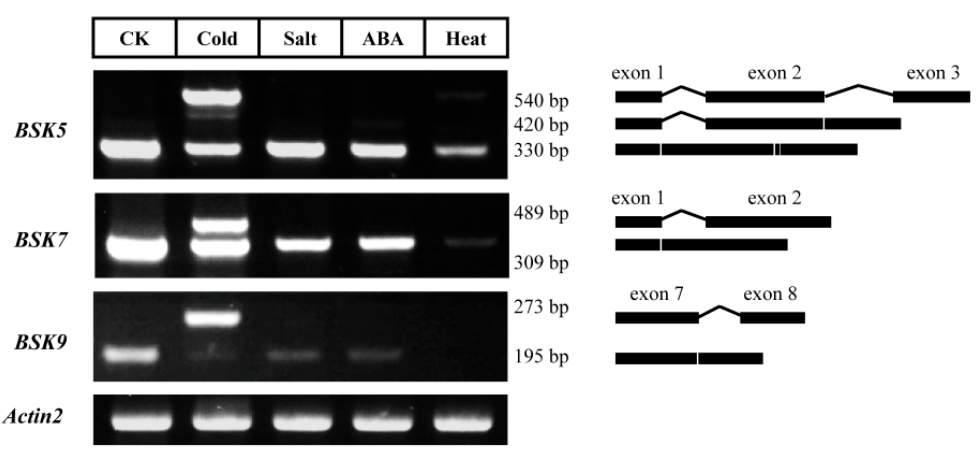
Figure 9. Intron retention analysis of BSK genes under stresses. Plants were stressed for 6 h under ABA/salt/cold and one hour under heat. Samples were then collected for mRNA isolation. Specific primers in exons were designed for RT-PCR in BSK genes. The detected PCR products were outlined on the